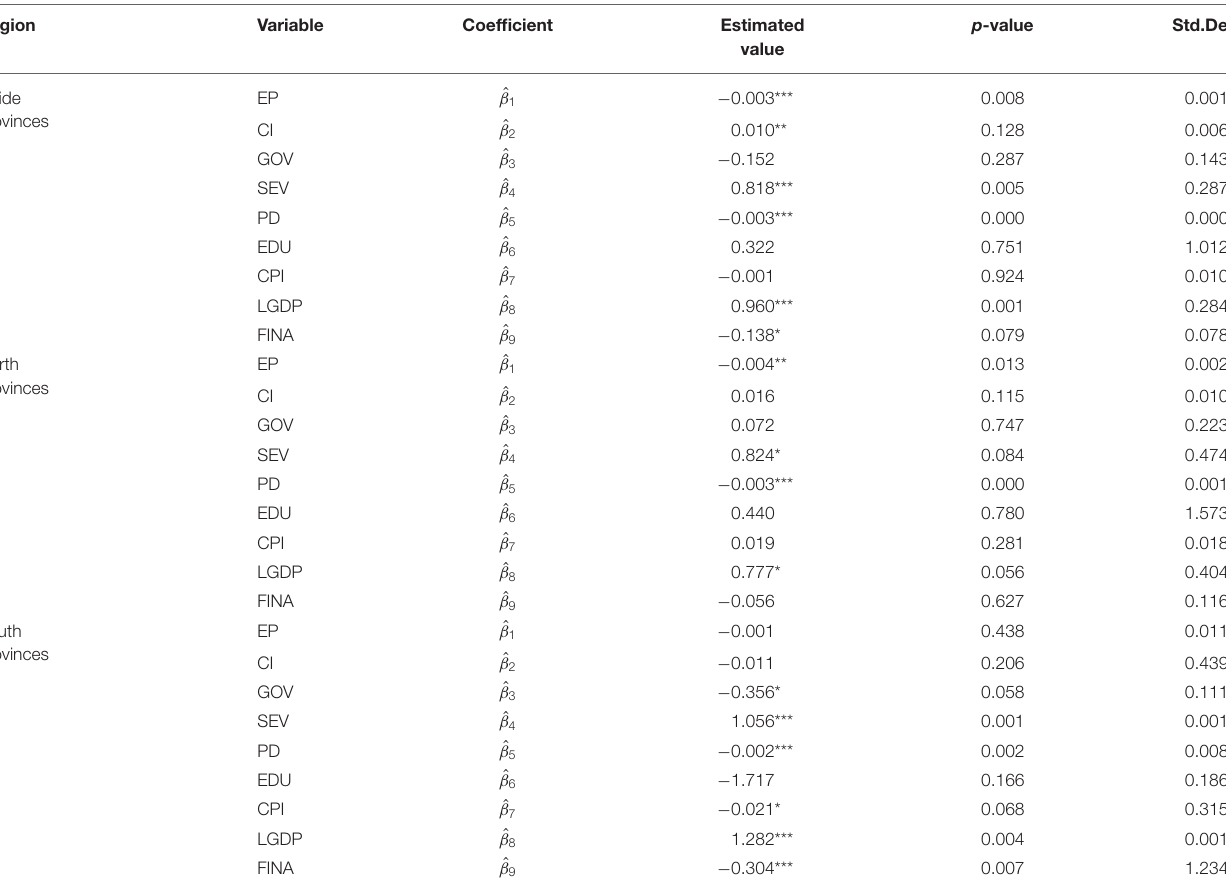
TABLE 7 | Estimated coefficients of the control